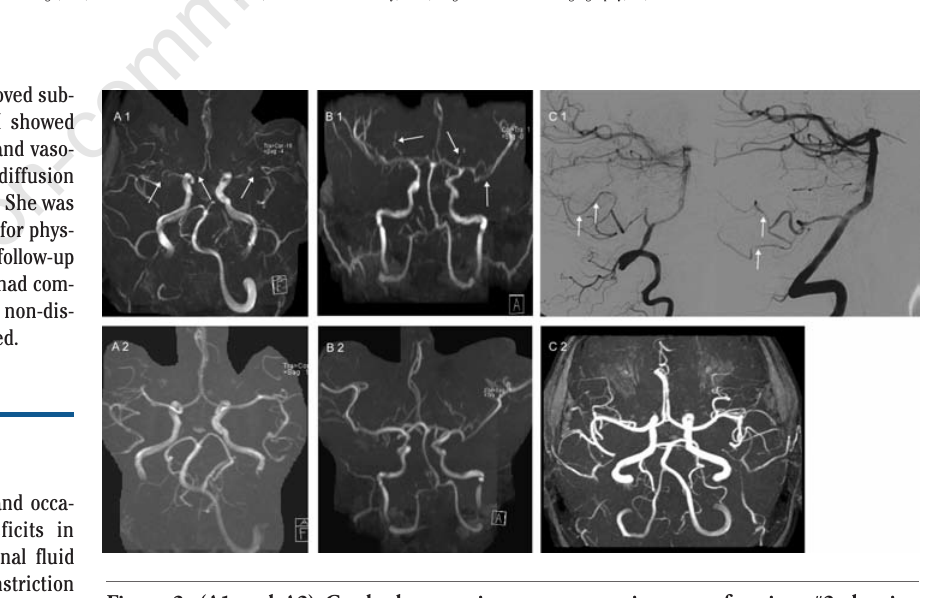
Figure 2. (A1 and A2) Cerebral magnetic resonance angiograms of patient #2 showing multi segmental vasoconstriction (white arrows, A1). Magnetic resonance angiography four months later (white arrows, A2) reveals normal vessel status. (B1 and B2) Magnetic reso- nance angiography of patient #4 reveals multisegmental vessel narrowing (white arrows, B1). One year later (white arrows, B2) no vessel abnormality is evident. (C1 and C2) Digital subtraction angiography demonstrates segmental narrowing of vessels, predominantly in both posterior inferior cerebellar arteries (white arrows, C1). Follow-up magnetic resonance angiography one year later shows normal vessel status (white arrows, C2).